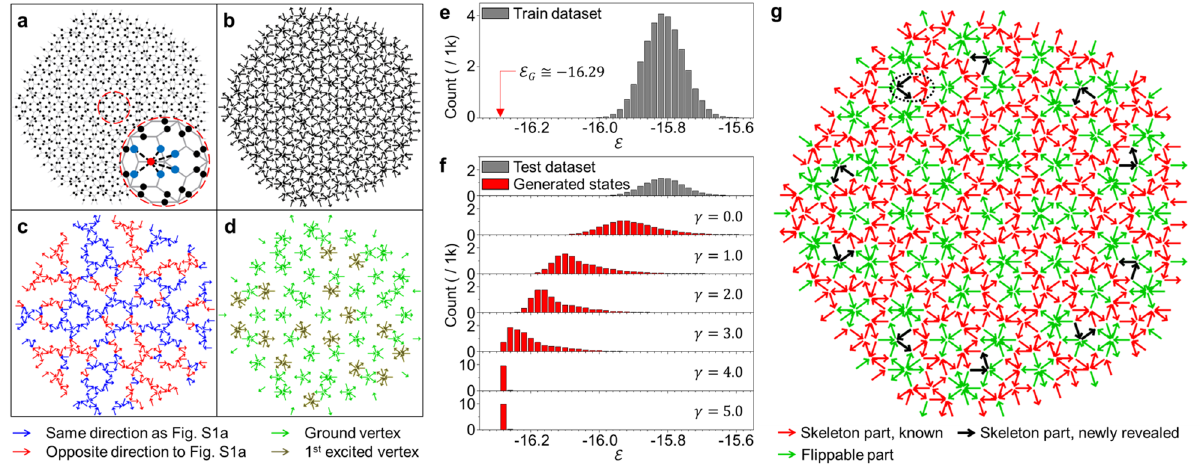
Figure 2. Structure and generated spin states of the Type-I Penrose P3 system. ( a ) The frame structure of Type-I system composed of 805 spins. Each circular dot represents where each spin is located. The sub-figure shows the dipole–dipole interaction scheme considered in this system, where blue dots indicate the spins interacting with the one on the red dot. ( b ) A sample spin state in the test dataset. ( c, d ) Spins of the spin state ( b ) that are located at the skeleton ( c ) and flippable ( d ) parts. ( e ) ε distribution for the training dataset. ε G indicates the energy density value of the proposed ground state. ( f ) ε distributions of the test dataset and the generated states from the trained E-VAE model with each γ value. ( g ) The lowest energy spin state obtained from a trained E-VAE model with γ = 5.0 . The black dotted circle represents the clockwise flow formed by the black and red